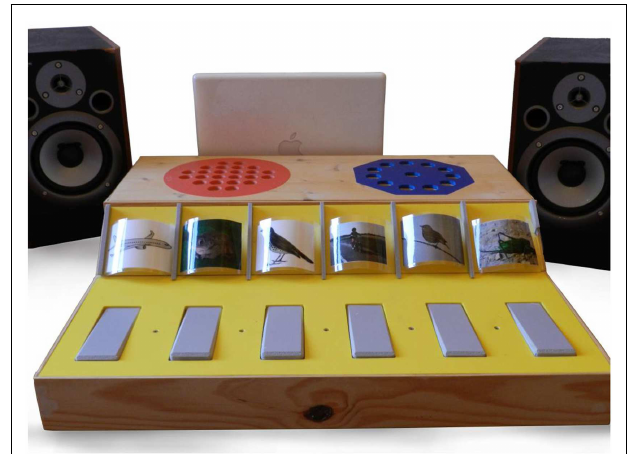
FIGURE 1 | Illustration of the “Sound in Hands” platform dressed for the identification task .